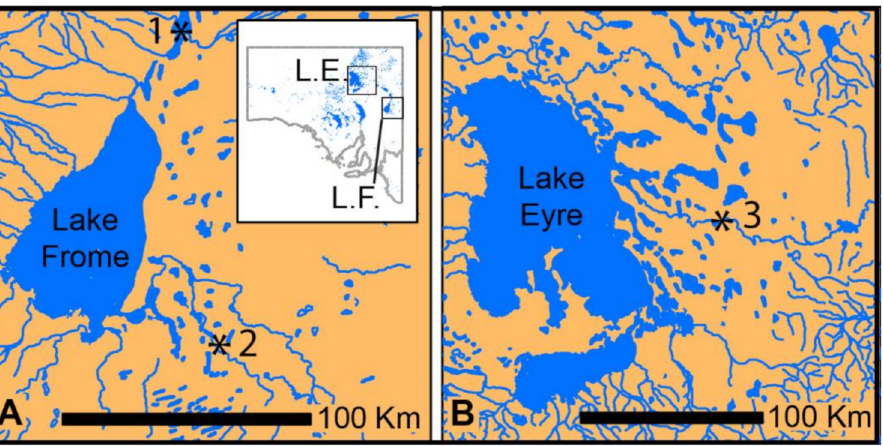
Figure 1. Sites in South Australia (inset) where the sampled bones of Genyornis were collected. ( A ) Lake Frome area (L.F.) and ( B ) Lake Eyre area (L.E.). 1, Lake Callabonna; 2, Billeroo Creek sites; 3, Cooper Creek sites (Malkuni Waterhole and Site